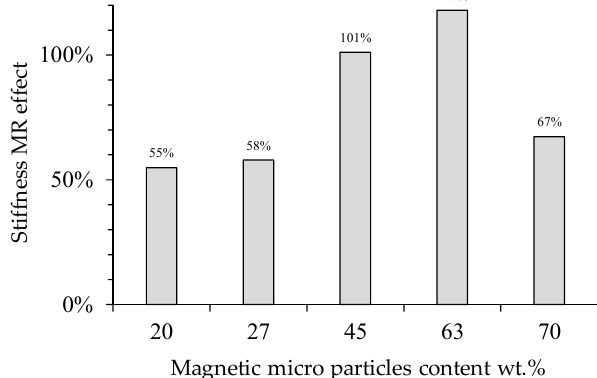
Figure 14. The stiffness magnetorheological (SMR) effect obtained for the composite materials when a 64 mT magnetic flux density is induced under static tensile load conditions. Here, the SMR effect was computed using the material stiffness under the magnetic flux density action with respect to those values obtained when the material samples were tested without a magnetic flux density.